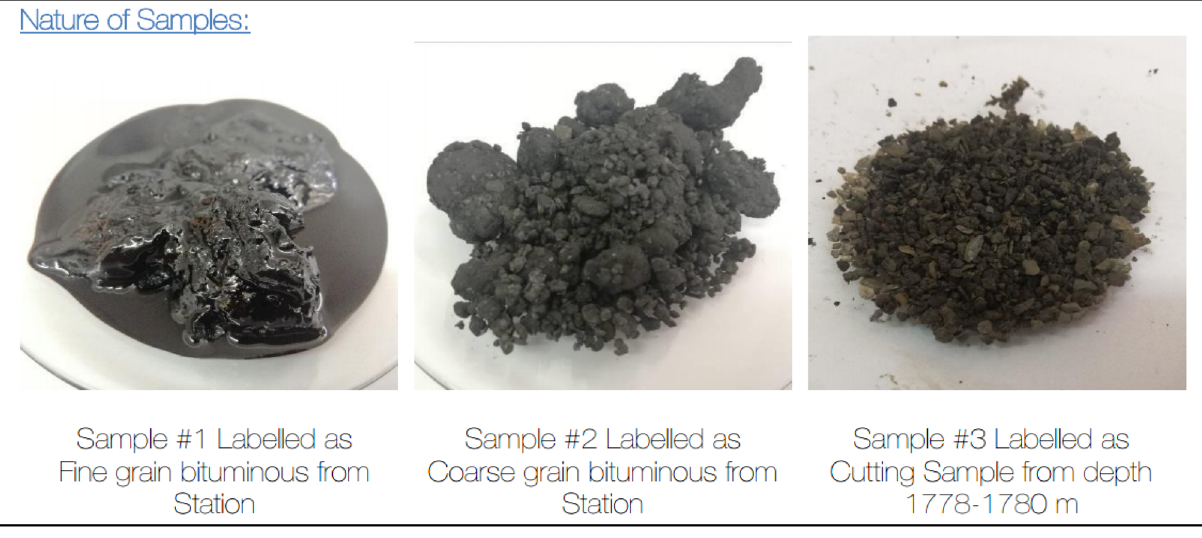
Fig. 18 Collecting Bitumen samples at production